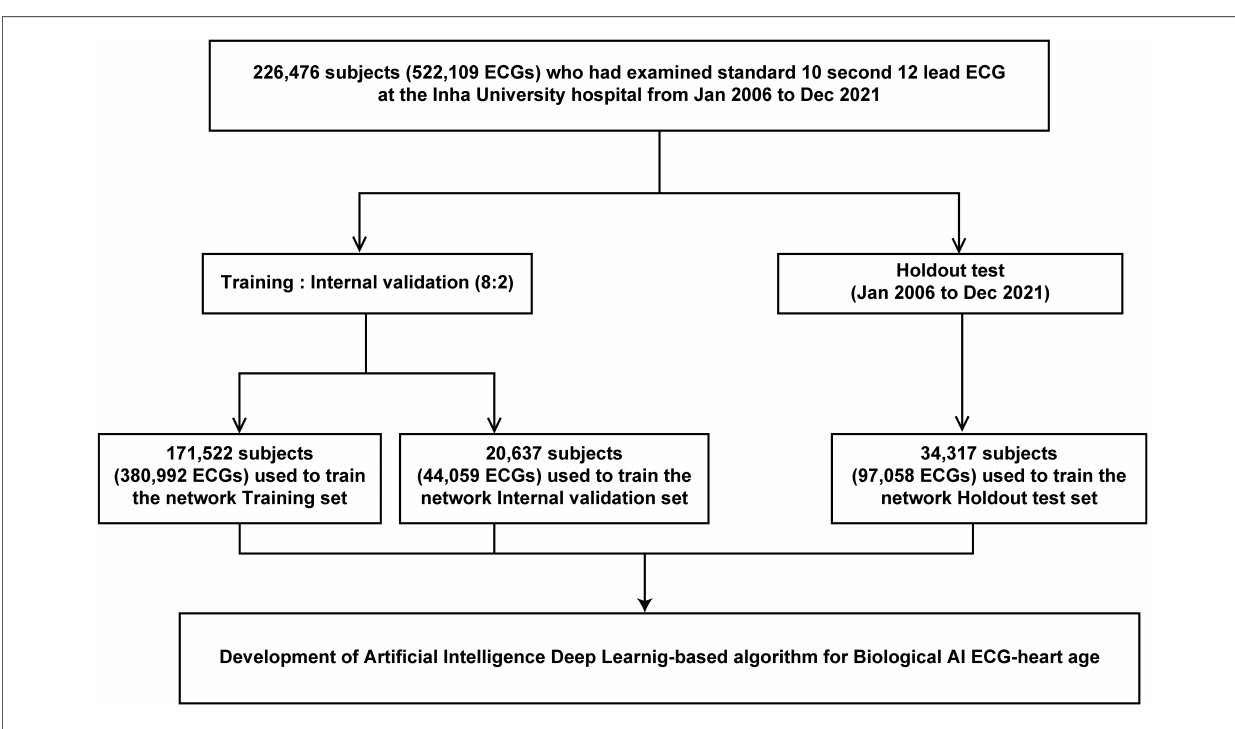
FIGURE 1 Creation of the study datasets. ECG,